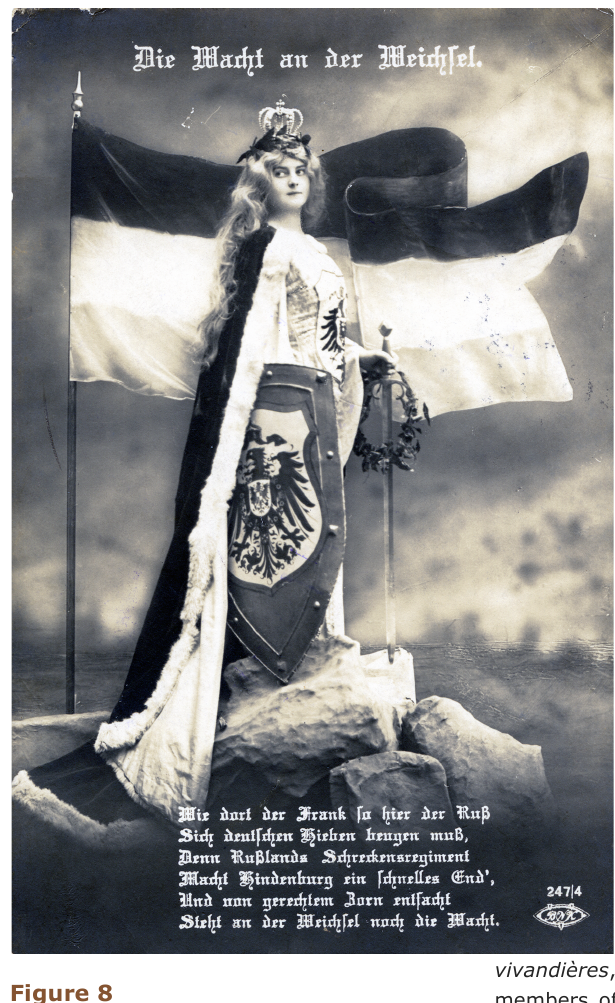
Artist unknown, Die Macht an der Weichsel (The Power on the Vistula). c. 1915. Postcard. Stiftung Historische Museen Hamburg-Altonaer